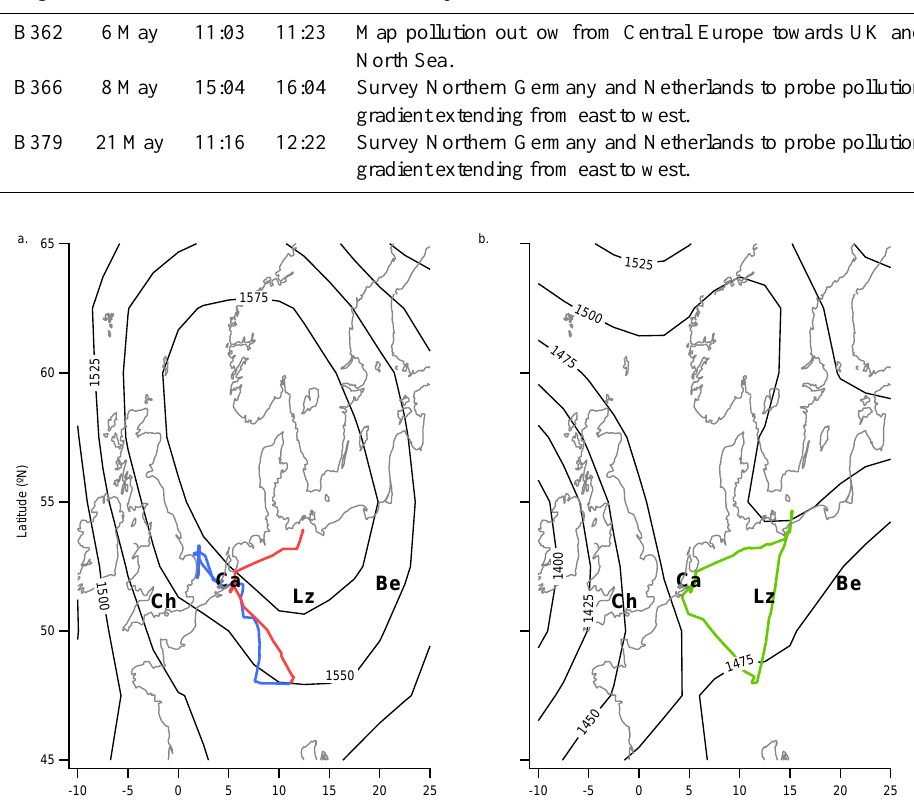
Fig. 1. Flight tracks of the BAe-146 considered by this analysis. Also shown are ECMWF 850hPa geopotential height fields. Panel (a) displays the flight tracks for B362 (6 May 2008, blue track) and B366 (8 May 2008, red track) and the geopotential height field is from 12:00 UTC on 6 May 2008. Panel (b) displays the flight track for B379 (21 May 2008, green track) and the geopotential height field is from the same date at 12:00 UTC. AERONET stations relevant to this study are marked, including Chilbolton (Ch), Cabauw (Ca), IFT-Leipzig (Lz) and Belsk